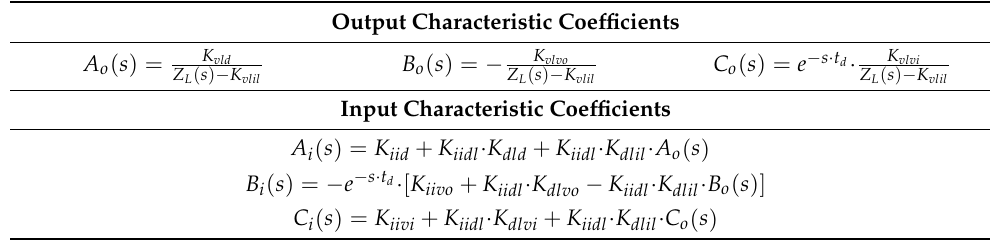
Table 2. Proposed characteristic coefficients of the PSFB converter.